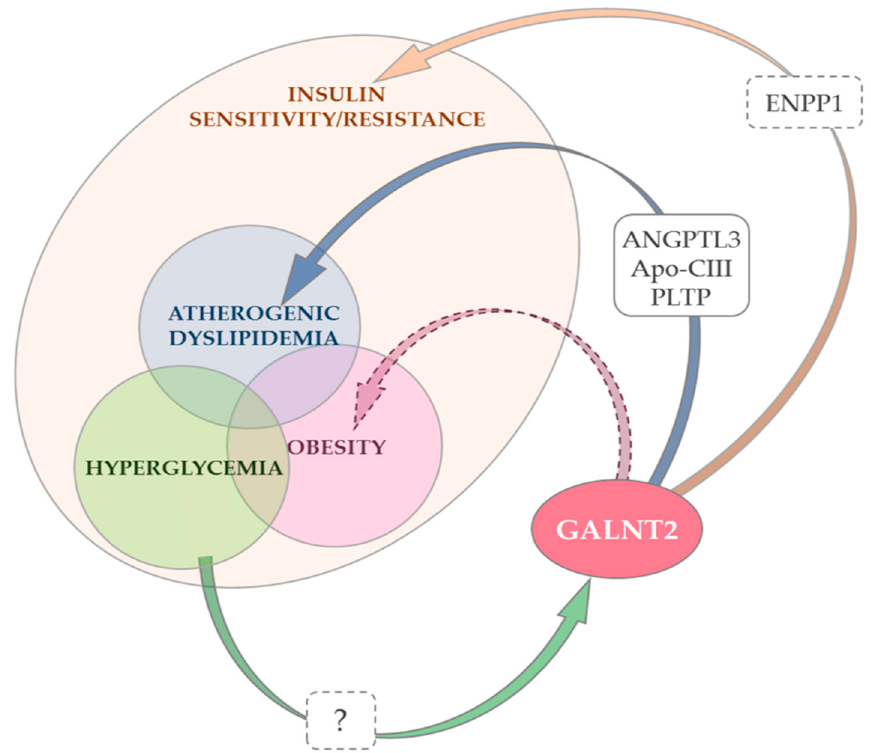
Figure 1. Changes in GALNT2 expression and/or function and insulin resistance, atherogenic dyslipidemia and obesity. Notes: GALNT2 promotes insulin action by down-regulating ectonucleotide pyrophosphatase/phosphodiesterase 1 ( ENPP1 ) [83], a negative modulator of insulin signaling [41–46] (orange arrow). Whether ENPP1 is a primary ppGalNAc-T2 target or its down-regulation is secondary to upstream O-glycosylation events is unknown (dashed box). The role of GALNT2 down-regulation in atherogenic dyslipidemia (low HDL-Cholesterol and/or high triglycerides) is best understood. This effect is mediated by the O-glycosylation of three established targets of ppGalNAc-T2 [9] (the product of GALNT2) (blue arrow). Although no data are currently available, it cannot be excluded that some of the deleterious effects of GALNT2 down-regulation on dyslipidemia are mediated by the concurrent deleterious effect on insulin signaling which, in turn, causes insulin resistance and low HDL-cholesterol/high-triglyceride levels [19]. Experimental data suggest that the effect of GALNT2 on adipocyte maturation, adipogenesis and eventually obesity is at least partly due to its positive modulation of insulin signaling [84]. Whether GALNT2 also affects adipogenesis through other mechanisms, possibly mediating coordinated changes in key genes affecting adipocyte maturation [84], is an alternative possibility that deserves further studies to be addressed (purple dashed arrow). Finally, a high glucose concentration decreases GALNT2 expression and this may play a role in hyperglycemia-induced insulin resistance (glucose toxicity) [15]. The mechanisms through which this down-regulation occurs are not known (green arrow, dashed box).